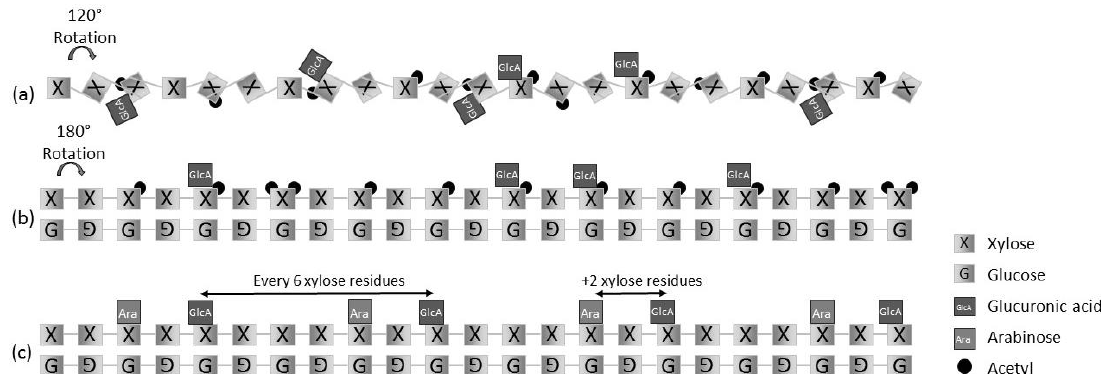
Figure 9. Xylan substitutions in hardwood and softwood. ( a ) Hardwood unevenly distributed substituents domain; every xylose has a rotation of 120 ˝ (three-fold screw). As the substitutions are uneven, the xylan cannot bind the cellulose chain made of glucose. ( b ) Hardwood evenly spaced substituents domain; every xylose has a rotation of 180 ˝ and all decorations face one side allowing the adsorption onto the cellulose. Unevenly and evenly distributed domains are probably on one xylan molecule of around 120 xylose residues. ( c ) Softwood xylan decoration; the glucuronic acids are every six xylose residues, and the arabinose are at plus two xylose residues from the glucuronic acid. This domain xylan molecule can be adsorbed onto the